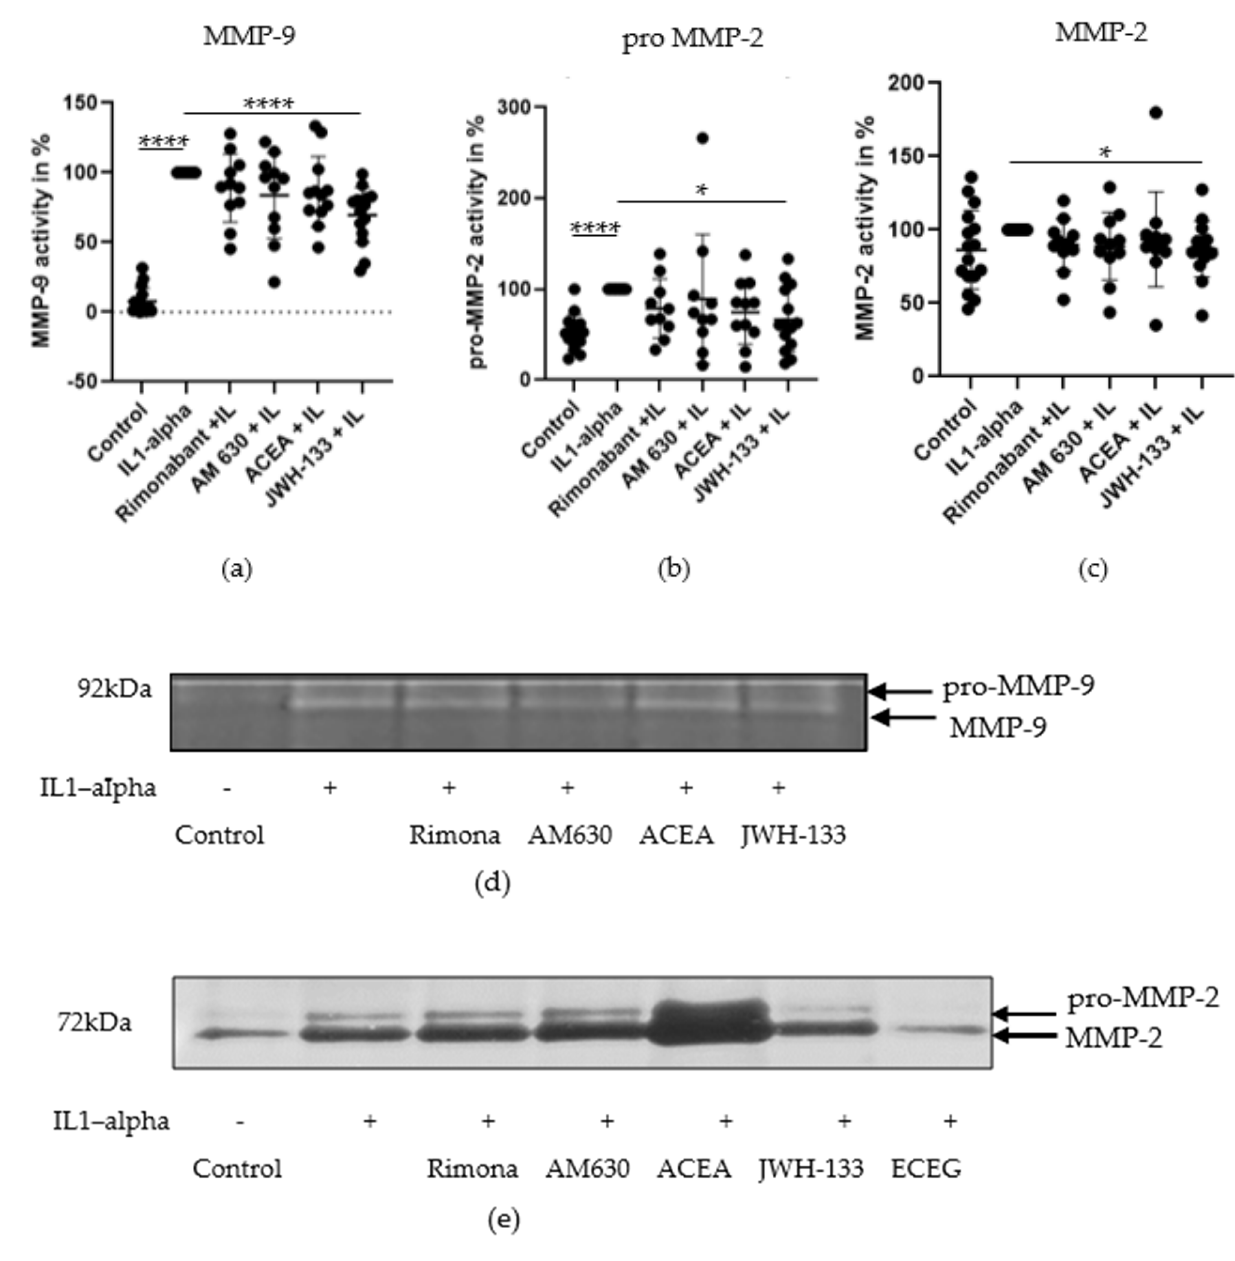
Figure 1. Effect of rimonabant (Rimona), AM630, ACEA and JWH-133 on IL-1 α -induced secretion of MMP-9 ( a ), proMMP-2 ( b ) and MMP-2 ( c ) in VSMCs, 48 h after treatment. The graphs represent the densitometric analysis (mean ± SD; n = 11). Statistical analysis performed with t -test with Welch’s correction, * p < 0.05; **** p < 0.0001. ( d ) MMP-9 activity, gelatin zymography, VSMCs, representative zymogram. ( e ) ProMMP-2, MMP-2 activity VSMCs, representative